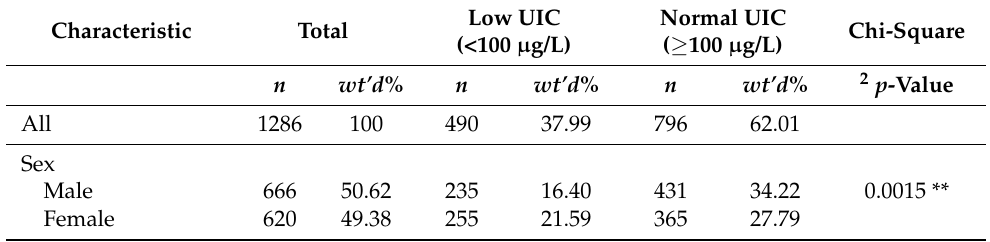
Table 1. Sociodemographic and lifestyle characteristics of study subjects, NHANES 2011–2012 1 , overall and by urinary iodine concentration 1